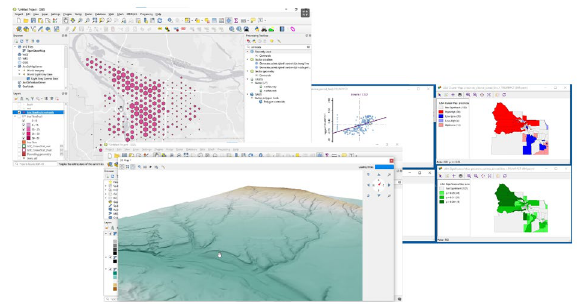
Figure 1 . Screen captures from video-led walkthrough exercises. Clockwise from top: Point pattern visualization using aggregation in QGIS, election analysis using Local Moran’s I in GeoDa, terrain visualization in